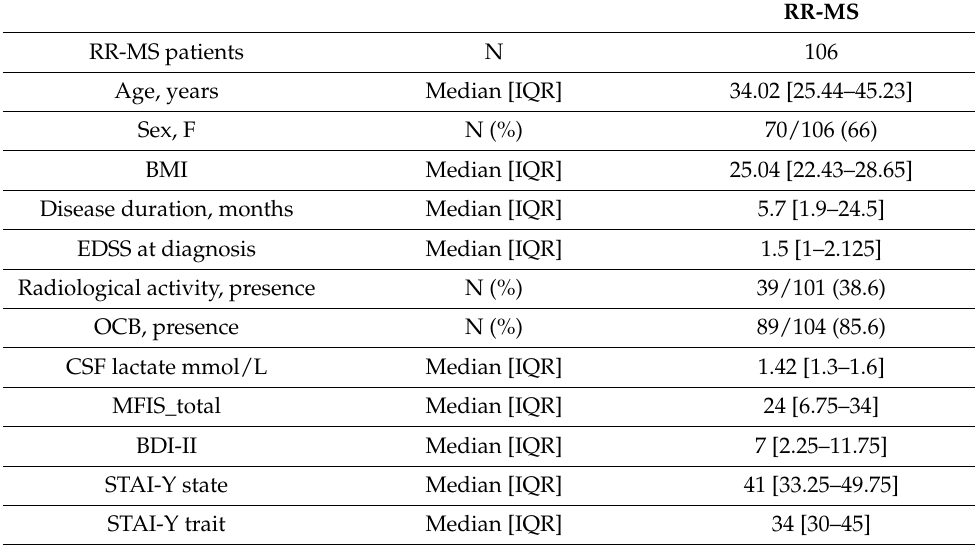
Table 1. Clinical characteristics at MS